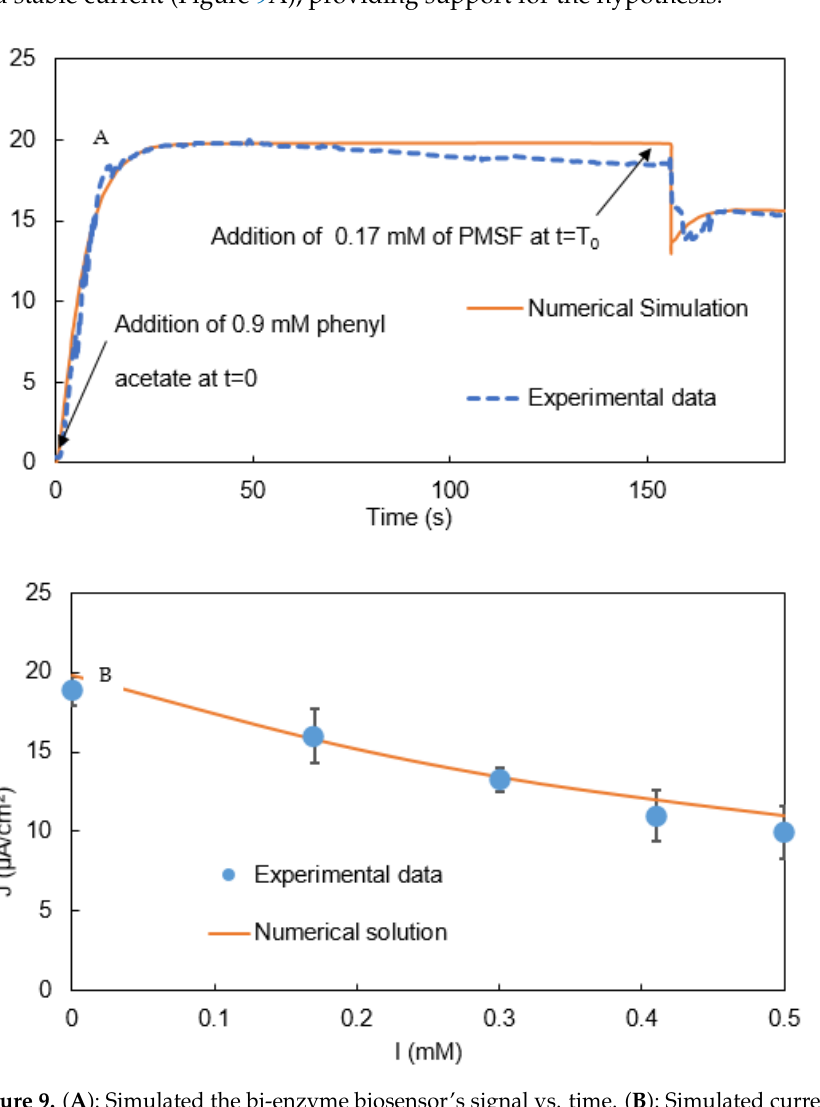
Figure 9. ( A ): Simulated the bi-enzyme biosensor’s signal vs. time. ( B ): Simulated current density vs. PMSF concentration (I). Error bars indicate the mean ± standard deviation of three replicates. Signal Amplification by Redox-Recycle Loop